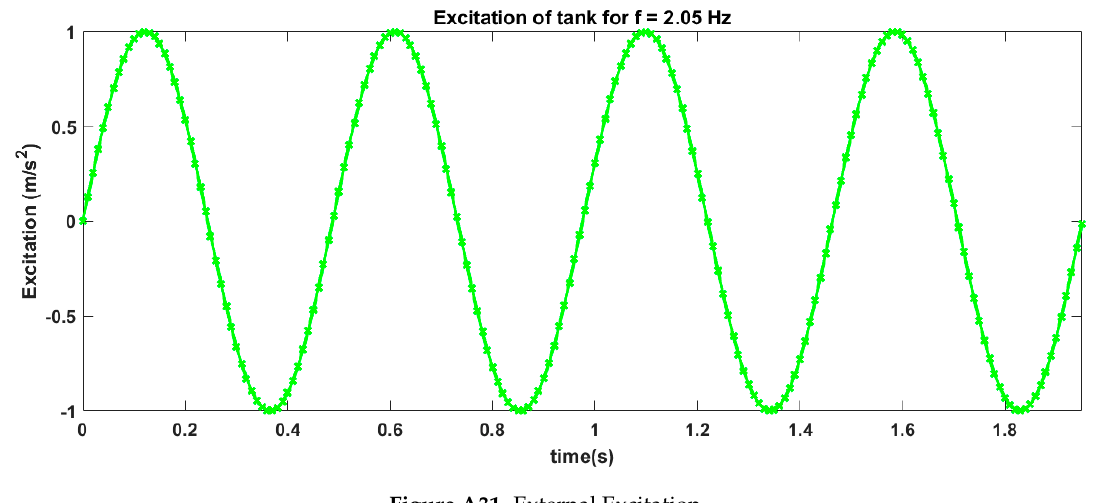
Figure A31. External Excitation.